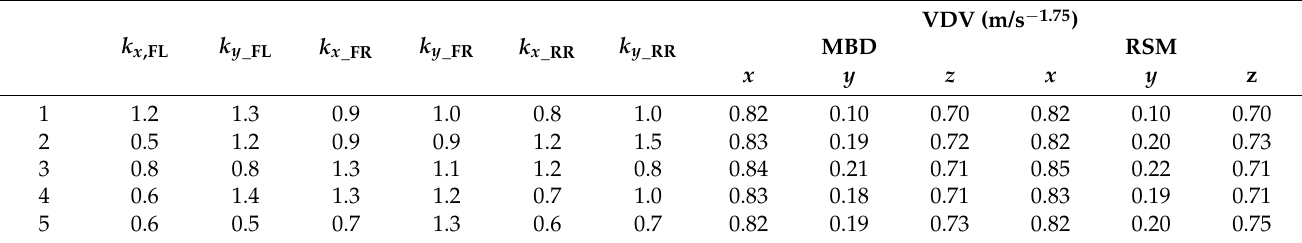
Table 2. Test samples and comparison of VDVs at the driver seat rail between multibody dynamics (MBD) and response surface method